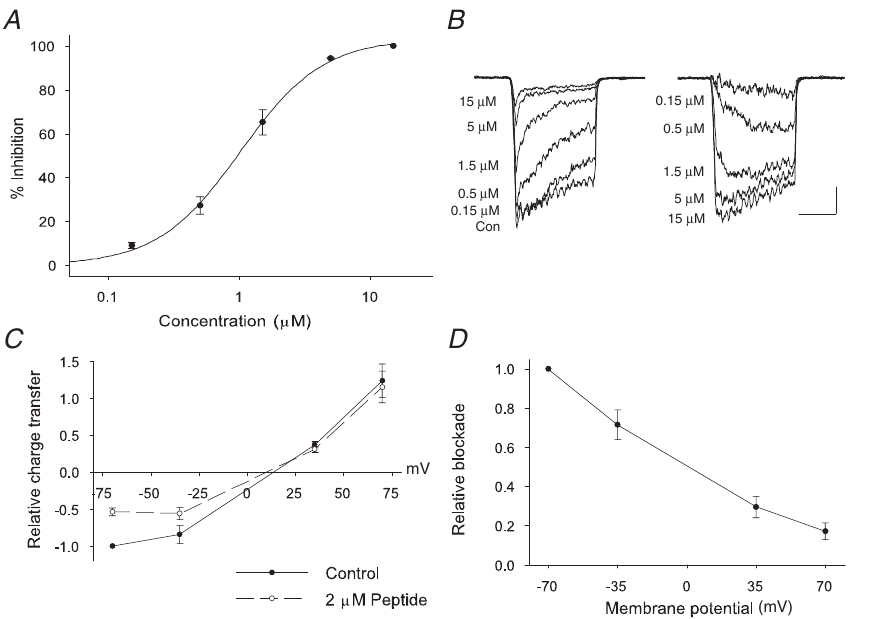
Figure 3. Blockade of SA currents by NMB-1 is concentration and voltage dependent. ( A ) Concentration-inhibition relationship for NMB-1 and SA currents; 4 neurons with SA currents were selected and 5 concentrations of NMB-1 (0.15 to 15 m M) were applied to each with full reversal in wash between application of the next concentration. The derived IC 50 was 1.0 m M and the Hill-coefficient was 1.4. ( B ) Example traces of currents in each concentration of NMB-1 ( left , as indicated) and the derived blocked current for each concentration ( right , as indicated). ( C ) Current-voltage relationship for currents in control conditions ( N ) and in the presence of 2 m M NMB-1 ( # ); all values are normalized to charge transfer in control solutions at 2 70 mV (n=3, mechanical stimuli applied for 100 msec). ( D ) Data from C shown as the relationship between fractional blockade by 2 m M NMB-1 and membrane potential; block declines linearly as the membrane is depolarized from 2 70 mV.